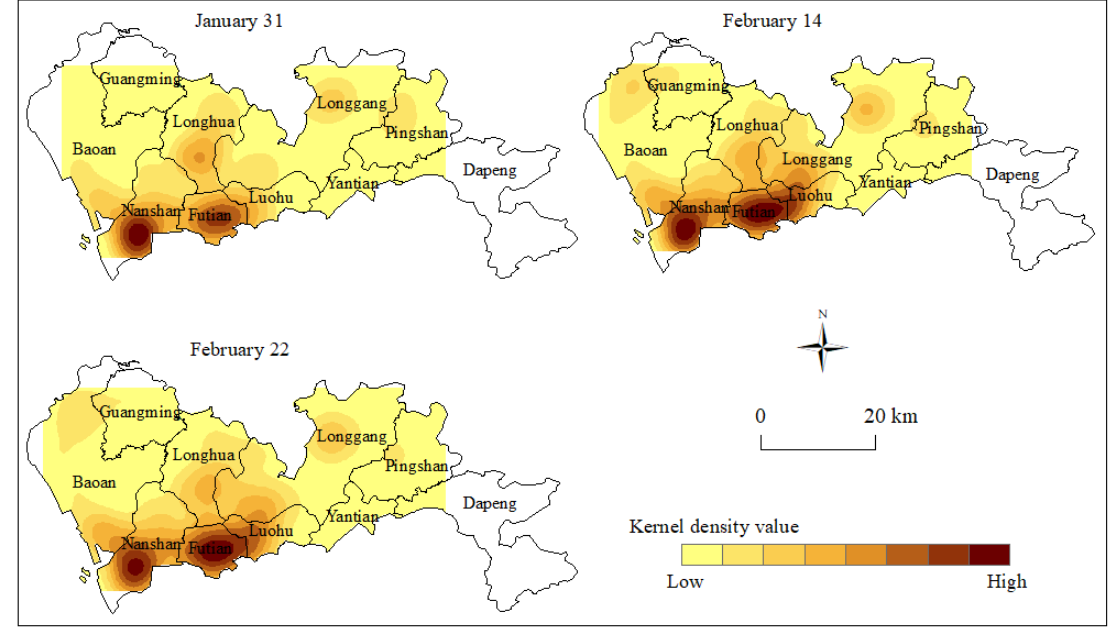
Figure 4. The kernel density of the spatial distribution of epidemic sites.